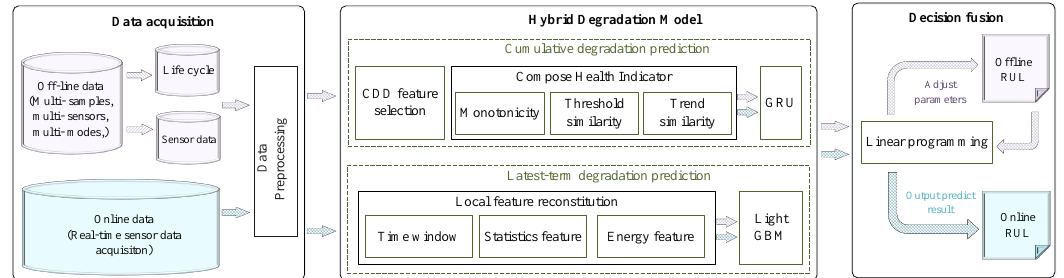
Figure 1. Structure of the proposed hybrid degradation model. The offline data are used to adjust parameters of prognostic model. The learned prognostic model is used to predict remaining useful life based on the online